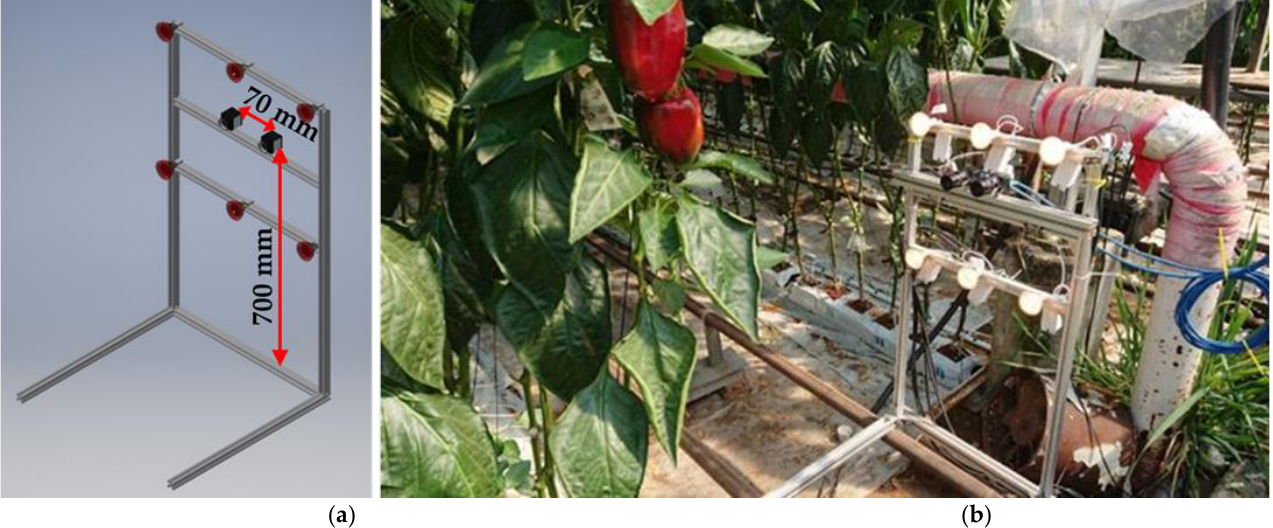
Figure 3. A structure for image acquisition ( a ) and image acquisition in the greenhouse ( b ).